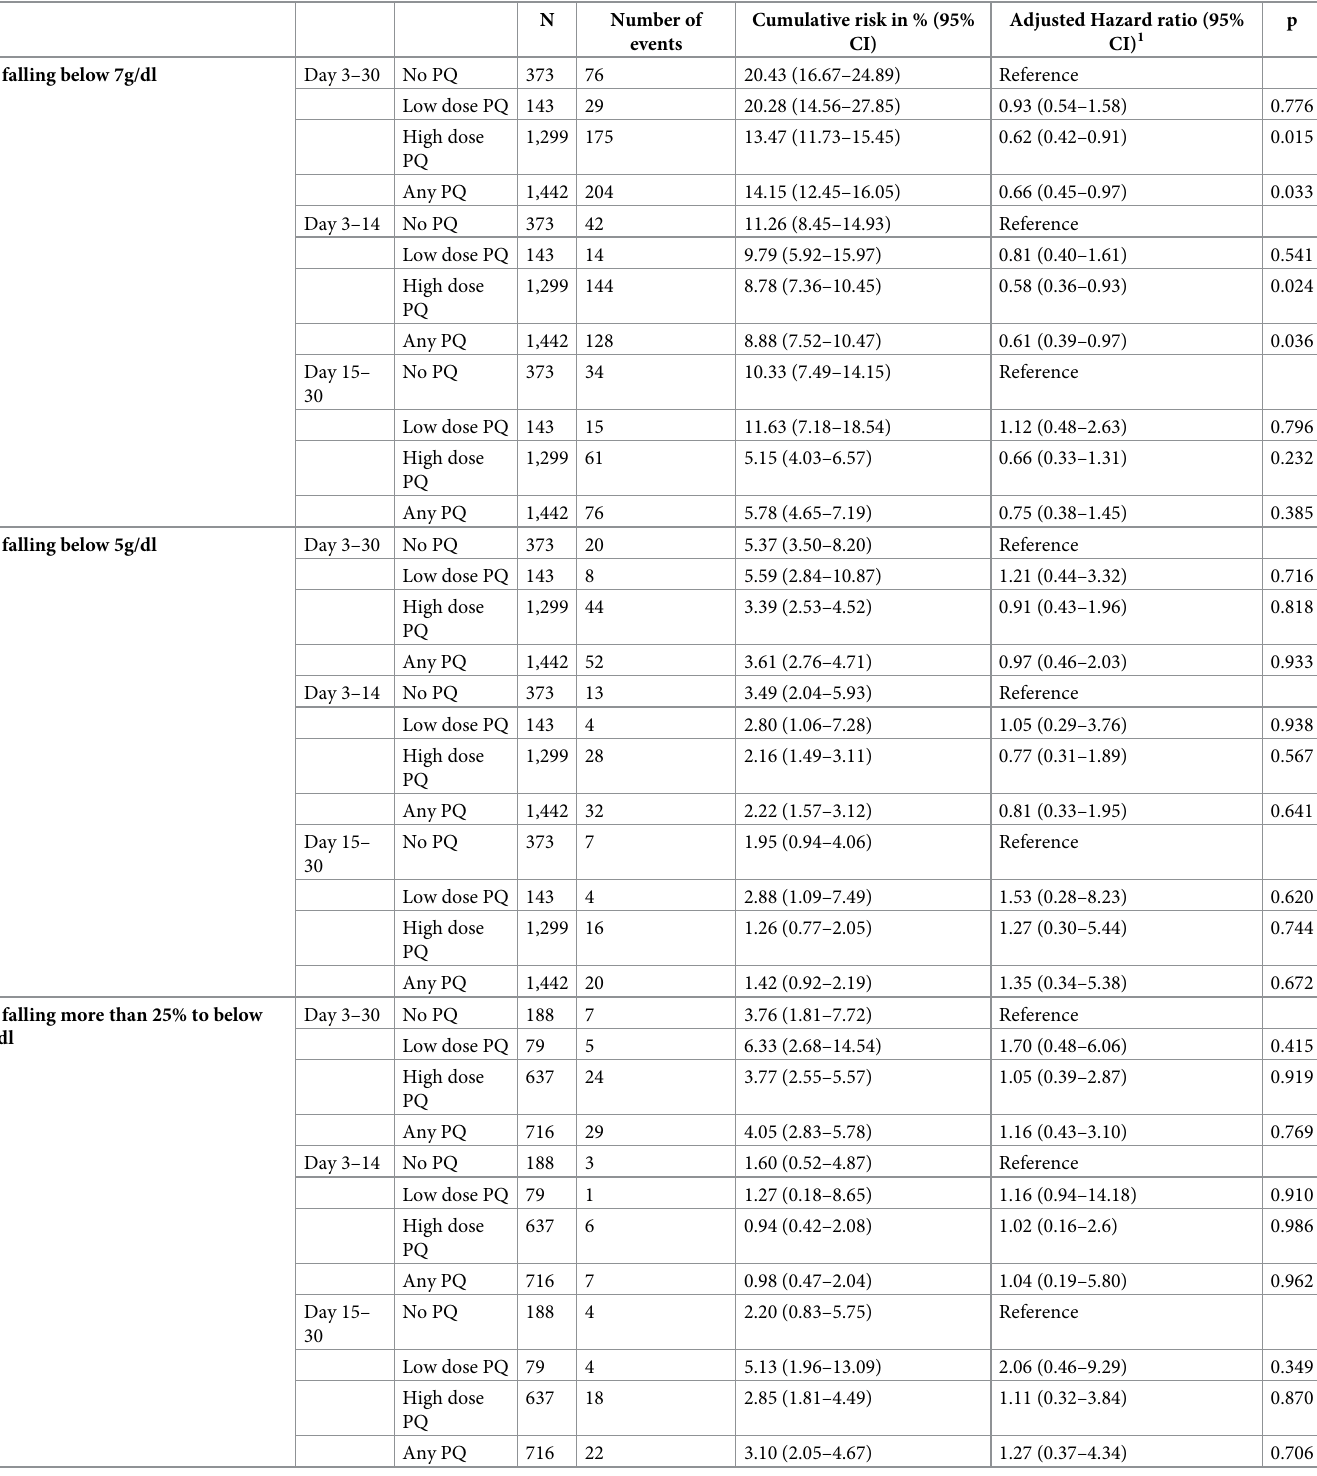
Table 4. Risk of anaemia within 30 days after any PQ dose and no